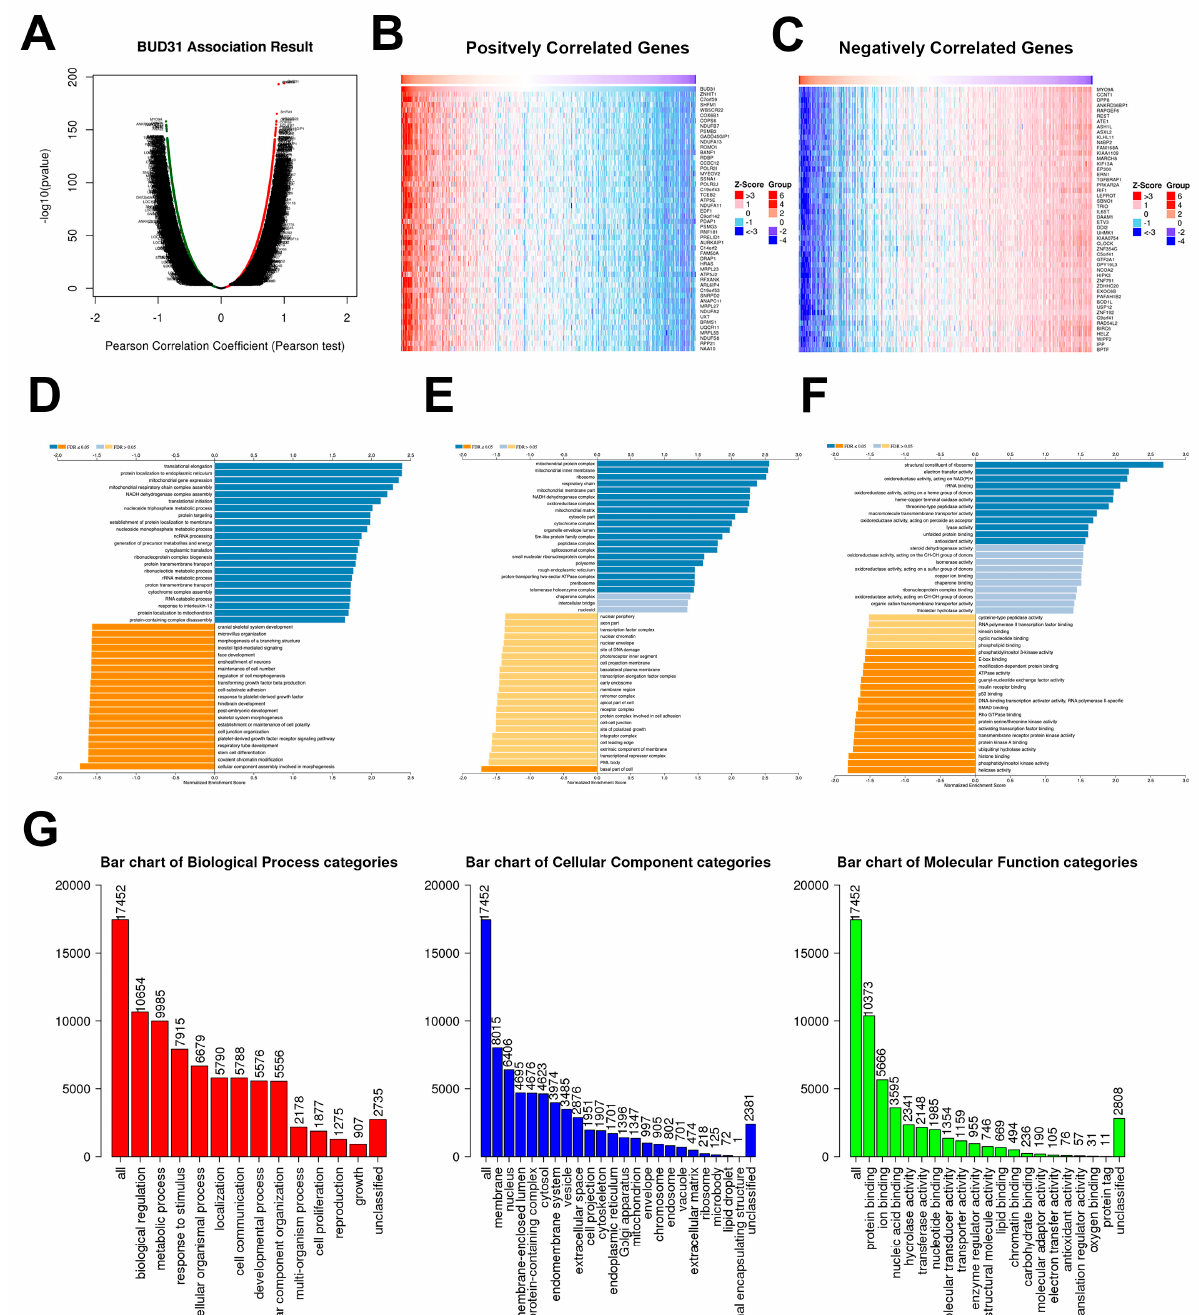
Figure 3. Gene set enrichment analysis for BUD31 from TCGA-PRAD RNA-seq of prostate cancer patients. ( A ) Volcano plot showing BUD31 -correlated genes, where red dots depict upregulated genes with positive Pearson correlation coefficients, whereas green dots show downregulated genes with negative Pearson correlation coefficients (FDR < 0.01). ( B , C ) Heatmap analysis demonstrating the most upregulated and downregulated genes. ( D – F ) Gene ontology (GO) enrichment analysis depicting the most positively and negatively correlated biological, cellular, and molecular processes, respectively. Ranking was done using Pearson correlation coefficients and FDR values. The FDR is calculated using the Benjamini-Hochberg method. ( G ) GSEA summary of the most upregulated biological, cellular, and molecular processes, ranked using FDR and number of IDs in the